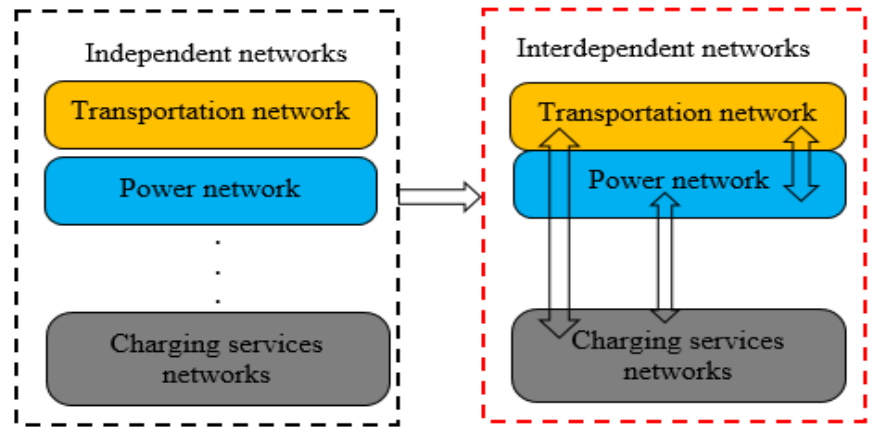
Figure 8. Development and formation of independent networks into interdependent networks.